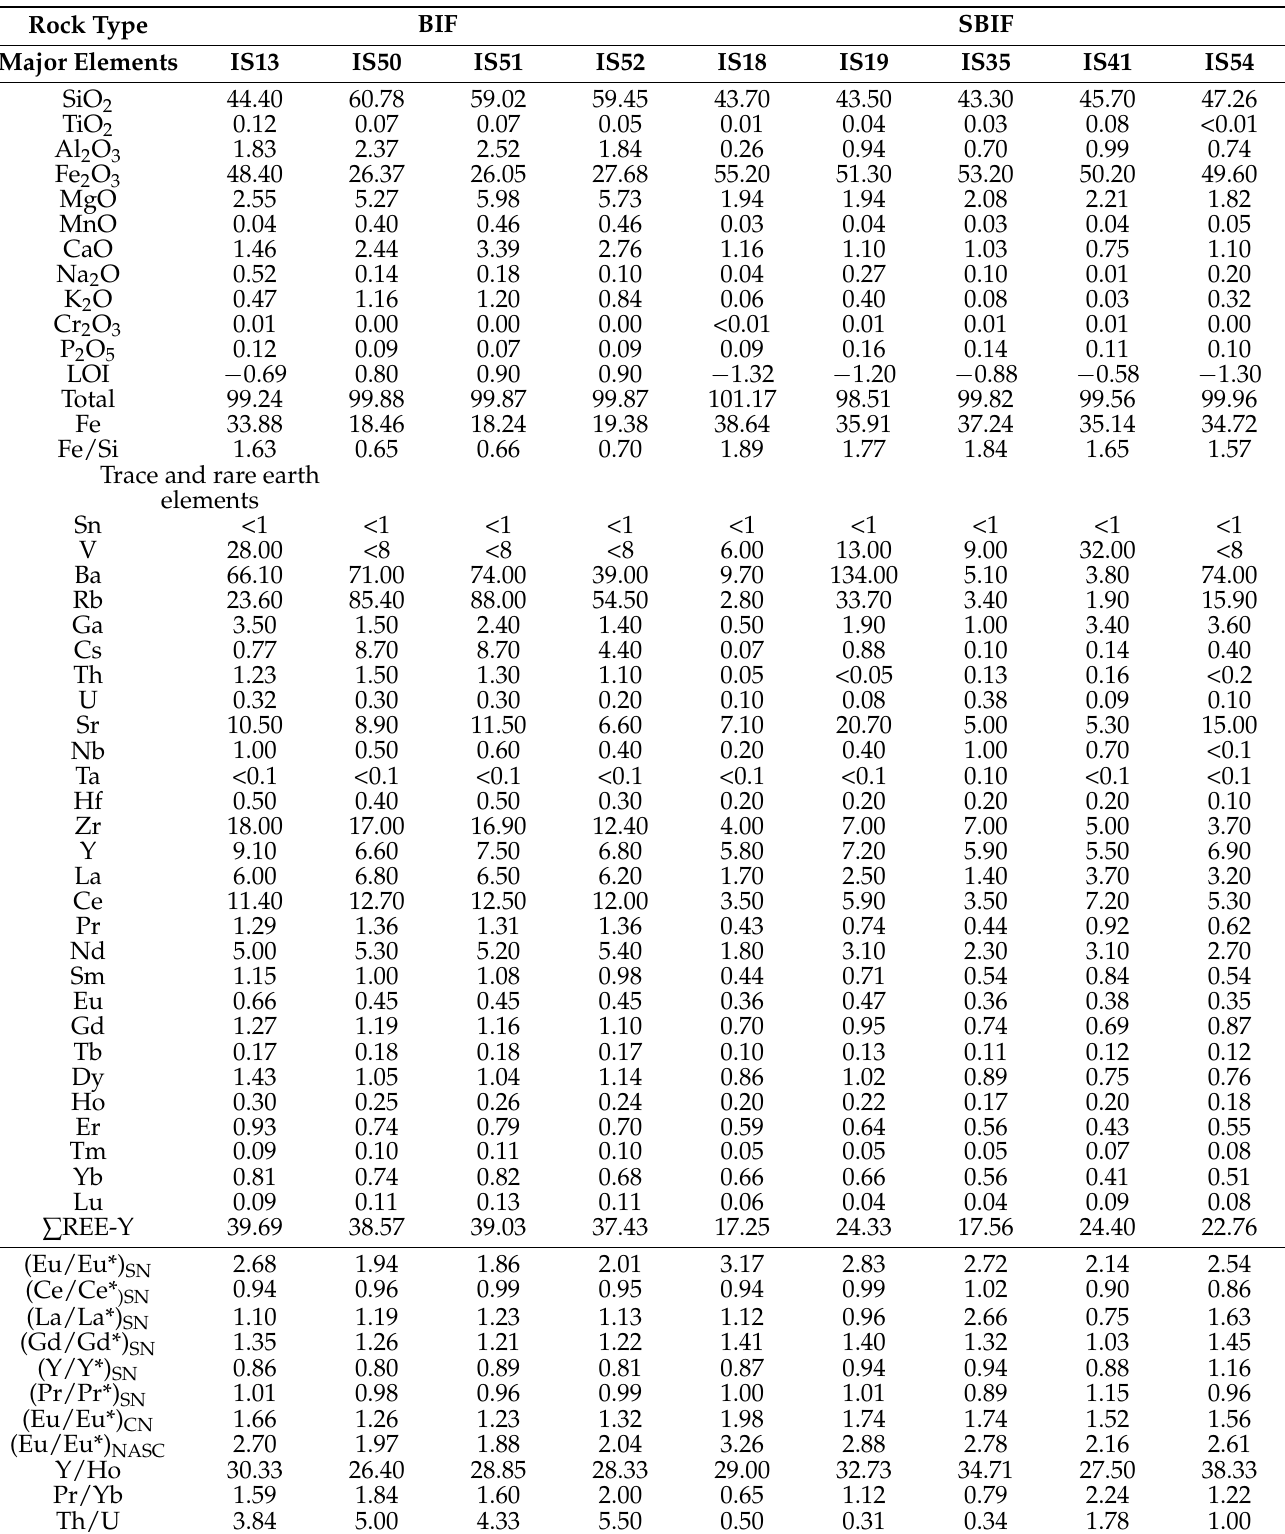
Table 2. Major elements (wt%) and trace elements (ppm) compositions of the Anyouzok Iron